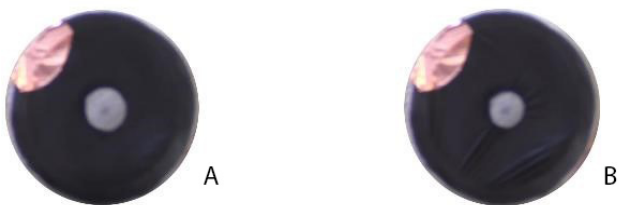
Figure 2. Inverted graphite dielectric elastomer actuator (DEA) silicone membrane tested in this study: ( A ) deactivated DEA (12 mm); ( B ) activated DEA (5 mm).